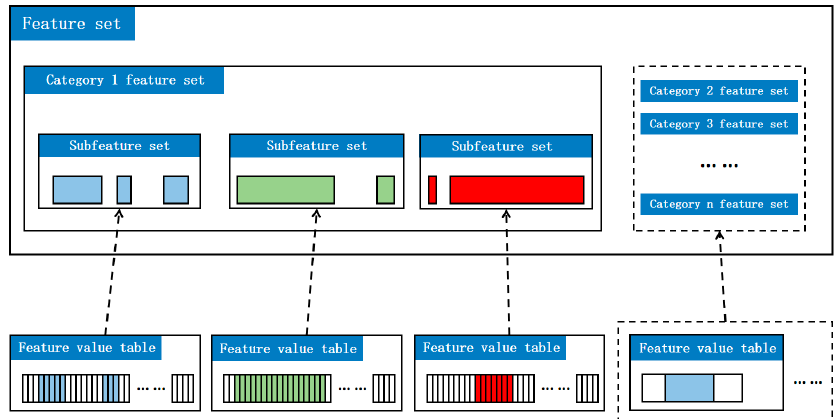
Figure 8. The relationship diagram.